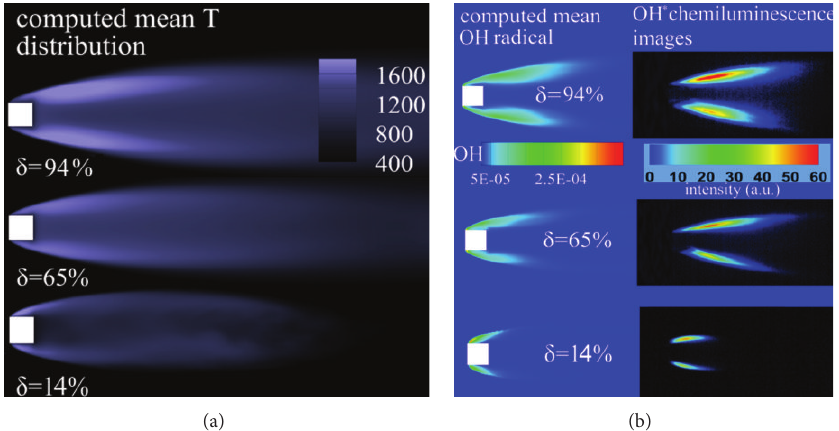
Figure 3: Simulated time-mean square burner wake characteristics, (a) temperature, (b) OH mole fraction radical and OH ∗ chemilumines- cence distributions for various ultra-lean flame